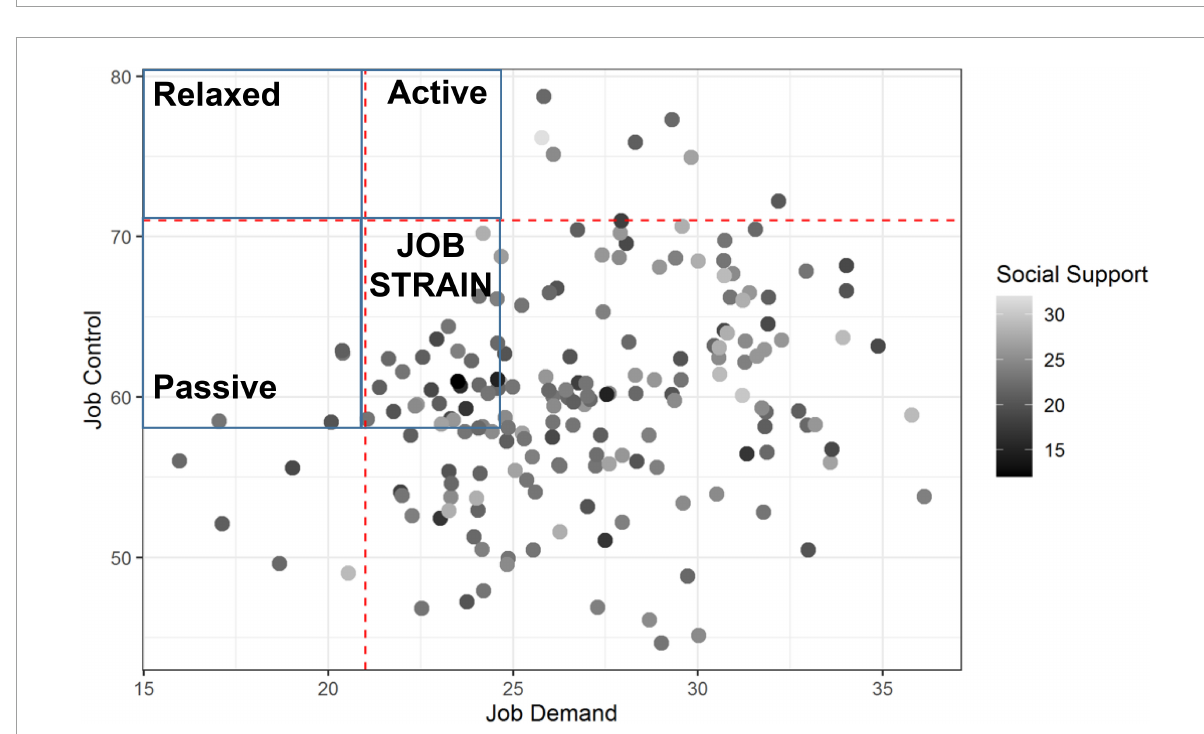
FIGURE3 All occupations from SUMER studies ( > 100,000 French participants) were within the four colored quadrants. Each dot represents an emergency healthcare worker from our study. Darker dots represent lower social support. Study of the validity of a job-exposure matrix for